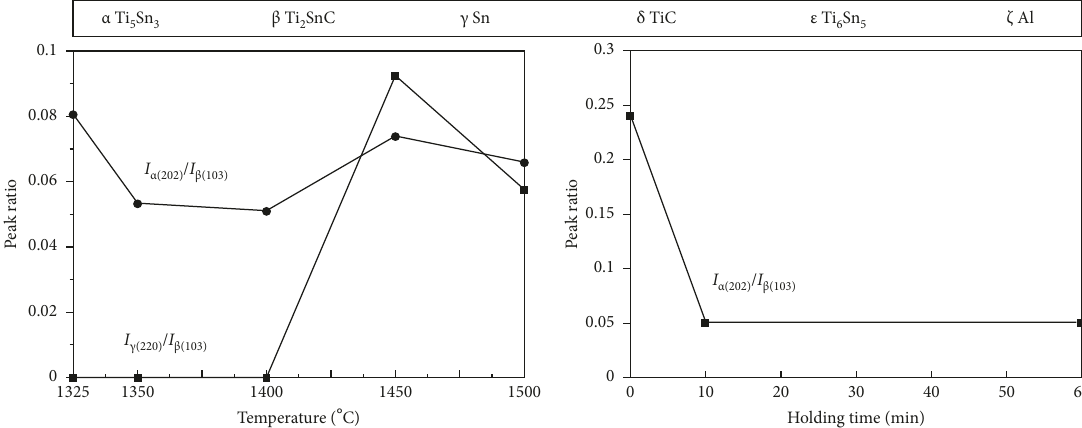
5 Sn 3 /Ti 2 SnC and Sn/Ti 2 SnC at a molar